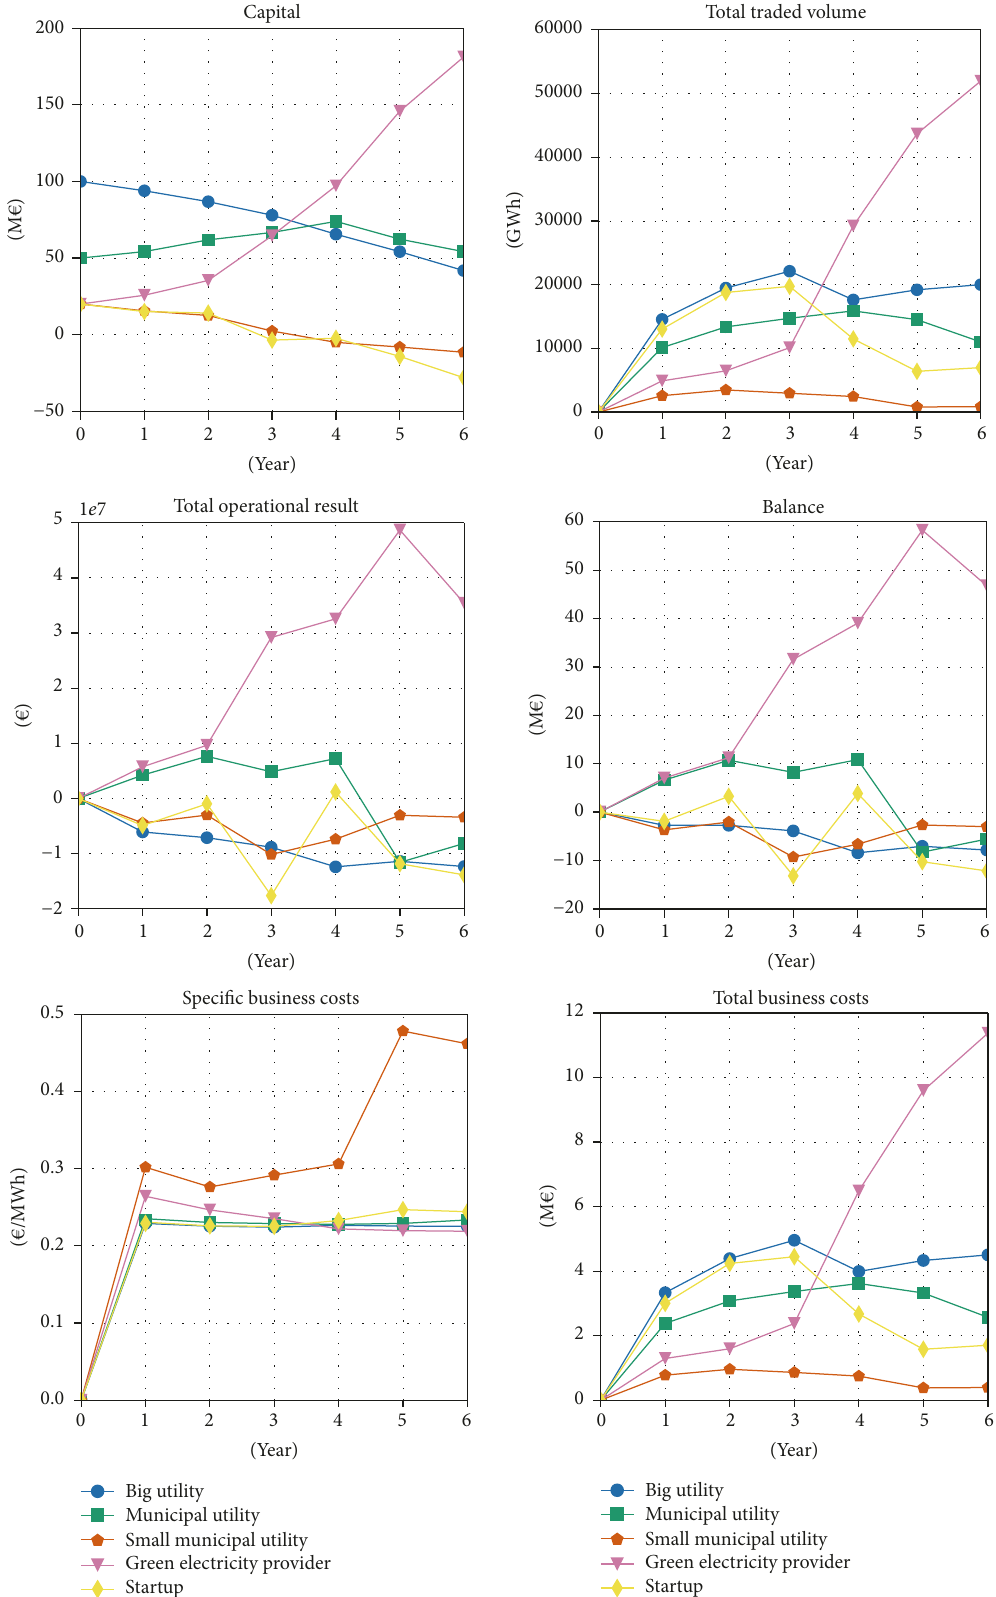
Figure10:Scenario2results.Thebalancereflectsallincomeandexpensesatthemarket,includingpaymentsforbalanceenergyandexcluding the business costs. Business costs are considered in the operational